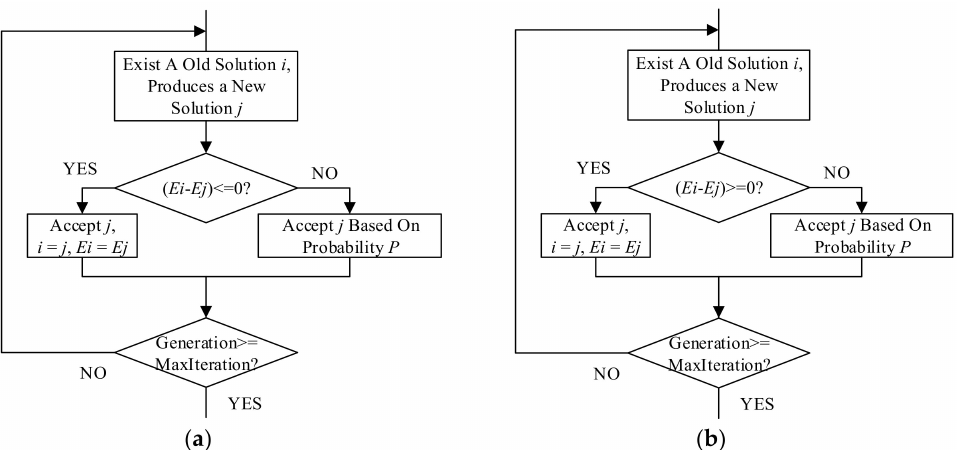
Figure 5. The flowcharts of the simulated annealing operation and the inverse annealing operation. ( a ) The simulated annealing operation; ( b ) The inverse simulated annealing